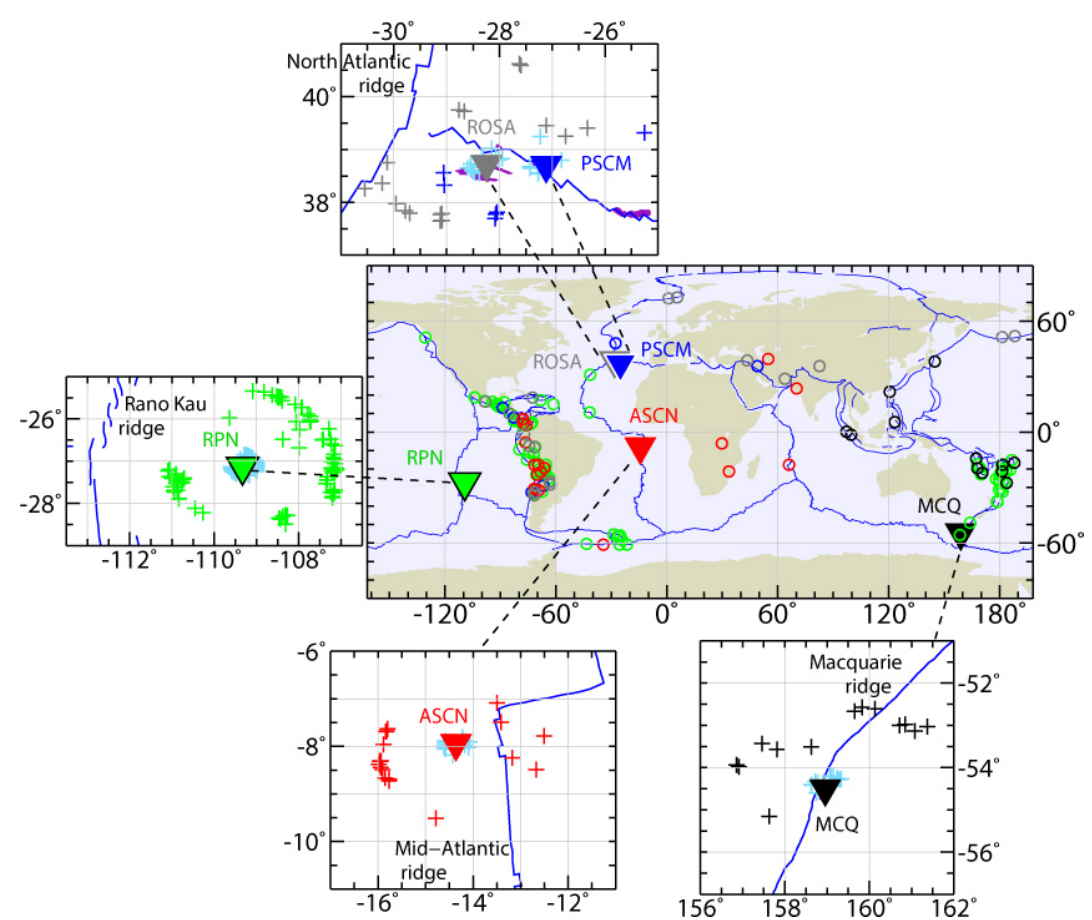
Figure 1. Location of the seismic stations (inverted triangles) used in the present study. Mid-oceanic ridge (MOR) boundaries are also shown (blue lines) with their names in the inset maps. The color code of the stations corresponds to the colors of the lines in Figs. 2 and 4. Open circles indicate the geographical distribution of the events corresponding to the stations of the same color. Insets corresponding to each station show their relative position with respect to the mid-oceanic ridges. The crosses in the insets are the P -to- S conversion points corresponding to the depths at 100km (cyan, nearest to the station) and at 520km (same color as the corresponding station, farther away).